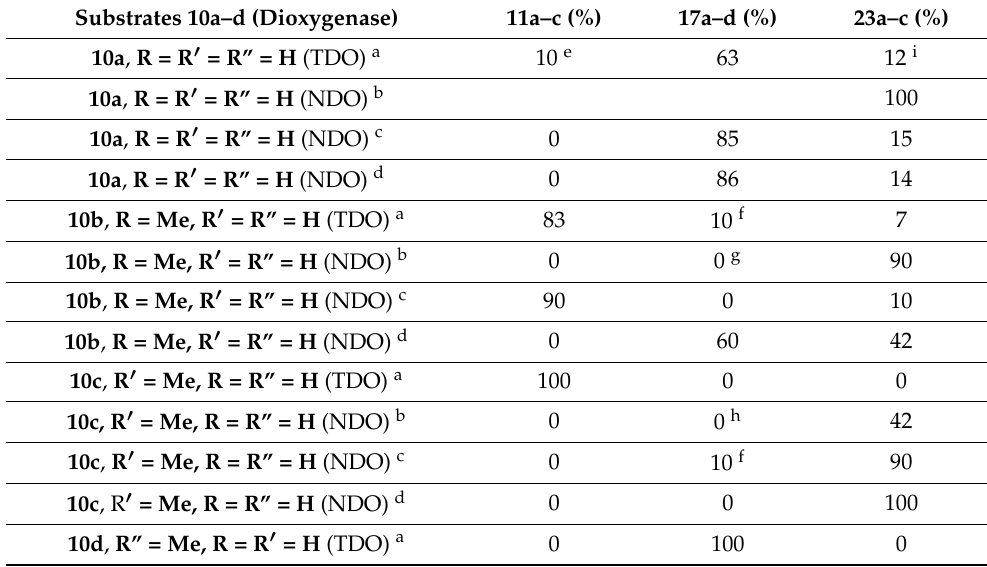
Table 3. Relative yields of metabolites from benzo[ b ] thiophenes 10a–d . Substrates 10a–d (Dioxygenase) 11a–c (%) 17a–d